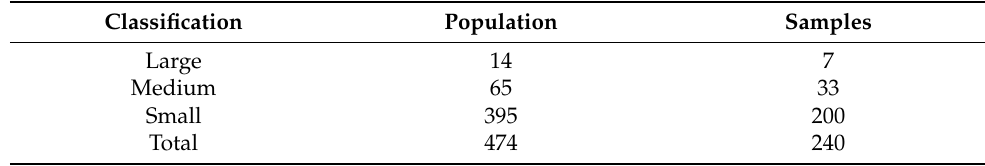
Table 2. Population and sample numbers. Source: APJII and stratified random sampling output.